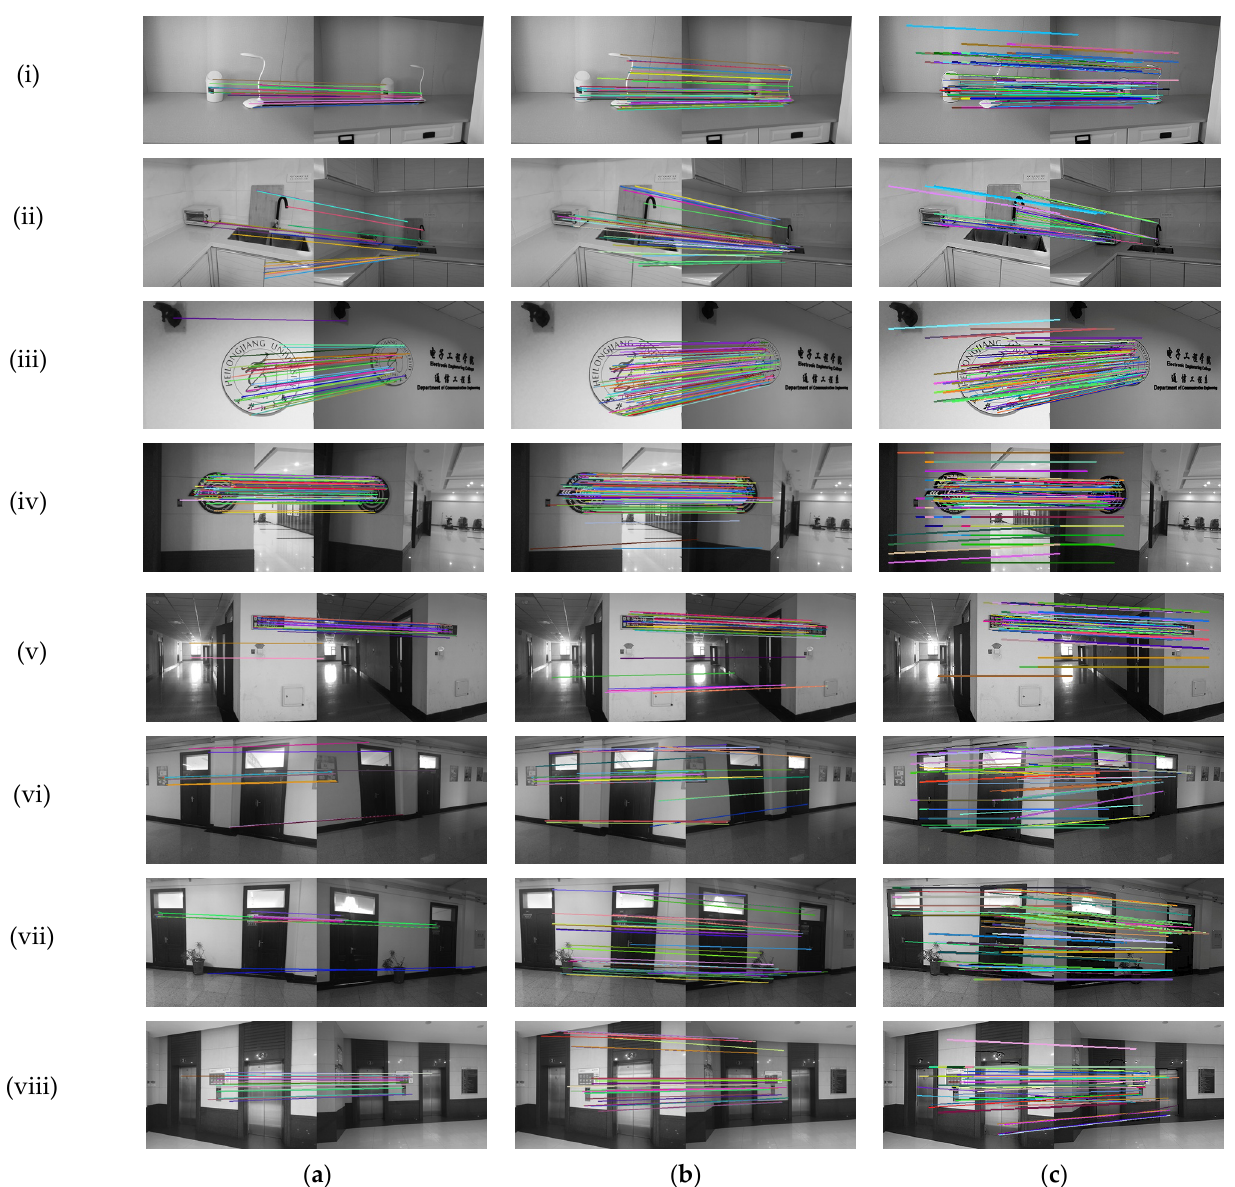
Figure 20. The effect of each feature matching method under the condition of illumination change and large-angle affine transformation: ( a ) SIFT; ( b ) SURF; ( c ) ARAC. Table 3. Matching results under the condition of illumination change and large-angle affine transformation. Matching